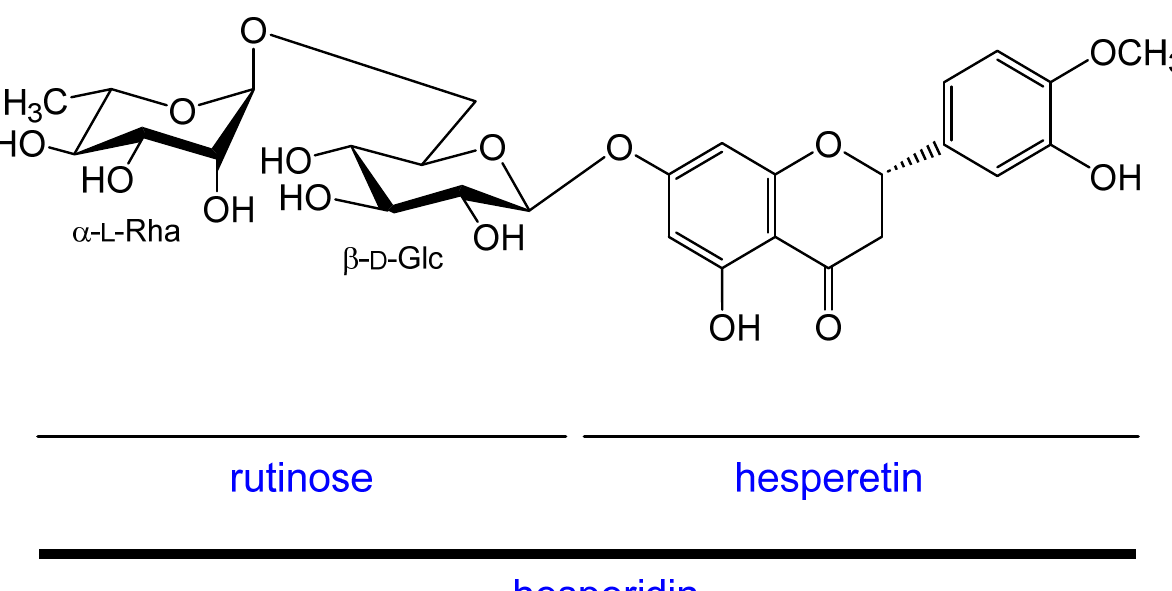
Figure 1. Structure of hesperidin.